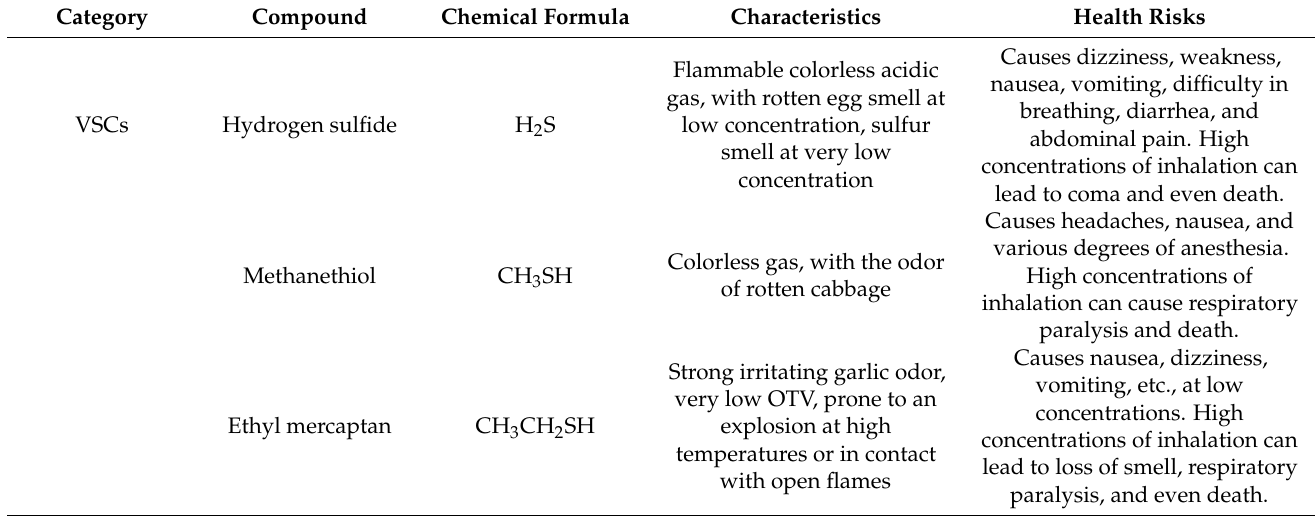
Table 2. Characteristics and health risks of common odorous substances in drainage systems